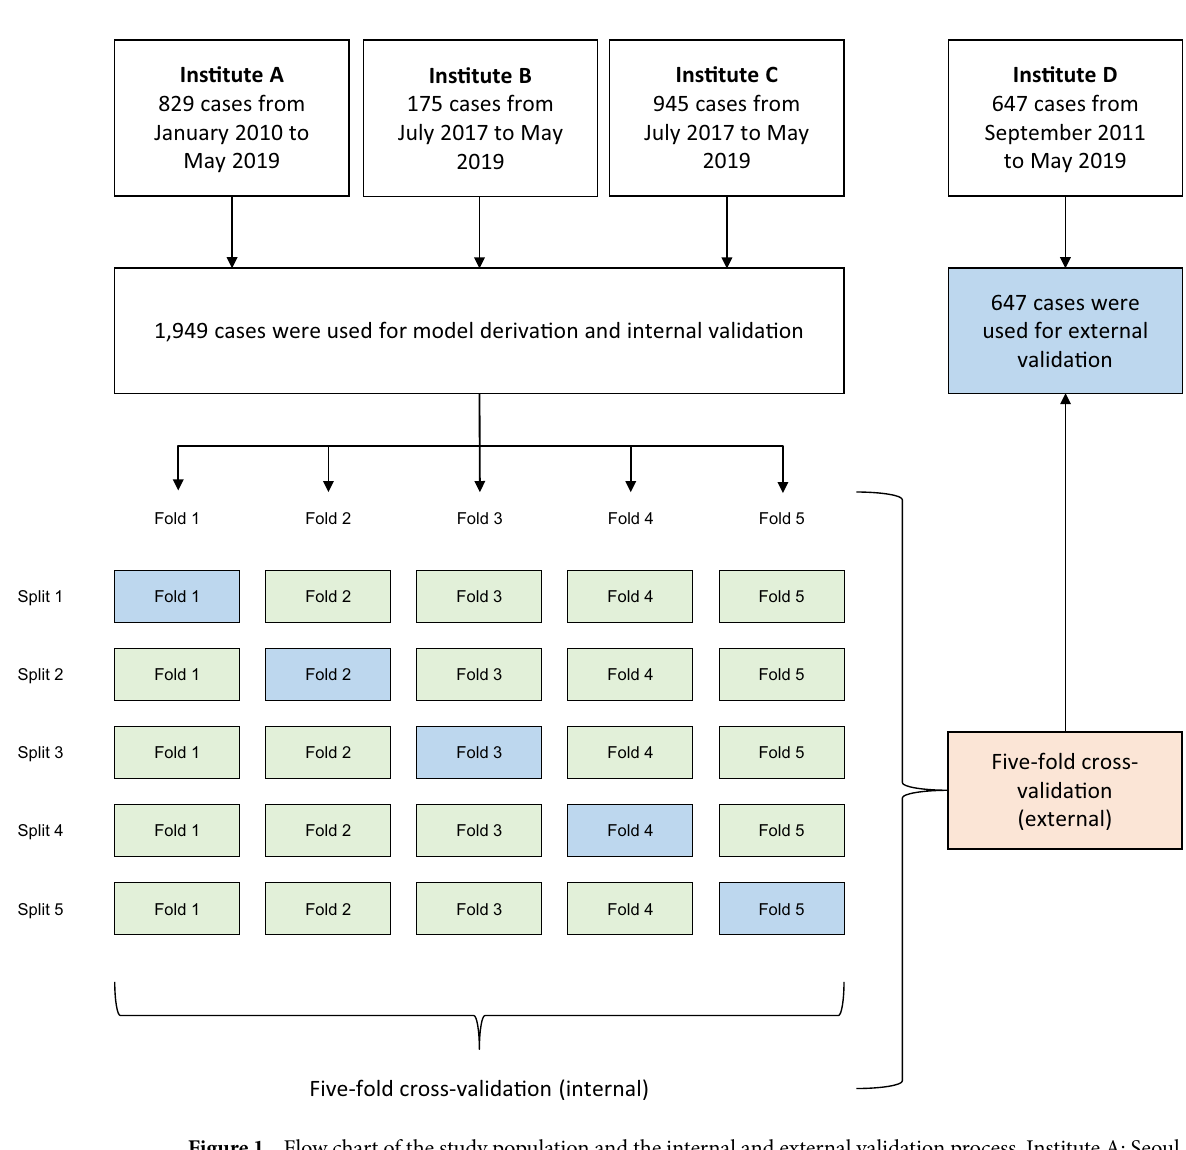
Figure S1 online. The importance of variables used in the RF model learned through Gini impurity was evaluated. The vari- ables used and their relative importance are shown in Fig. 3 with platelet, base excess, and potassium as the three most predictive values.